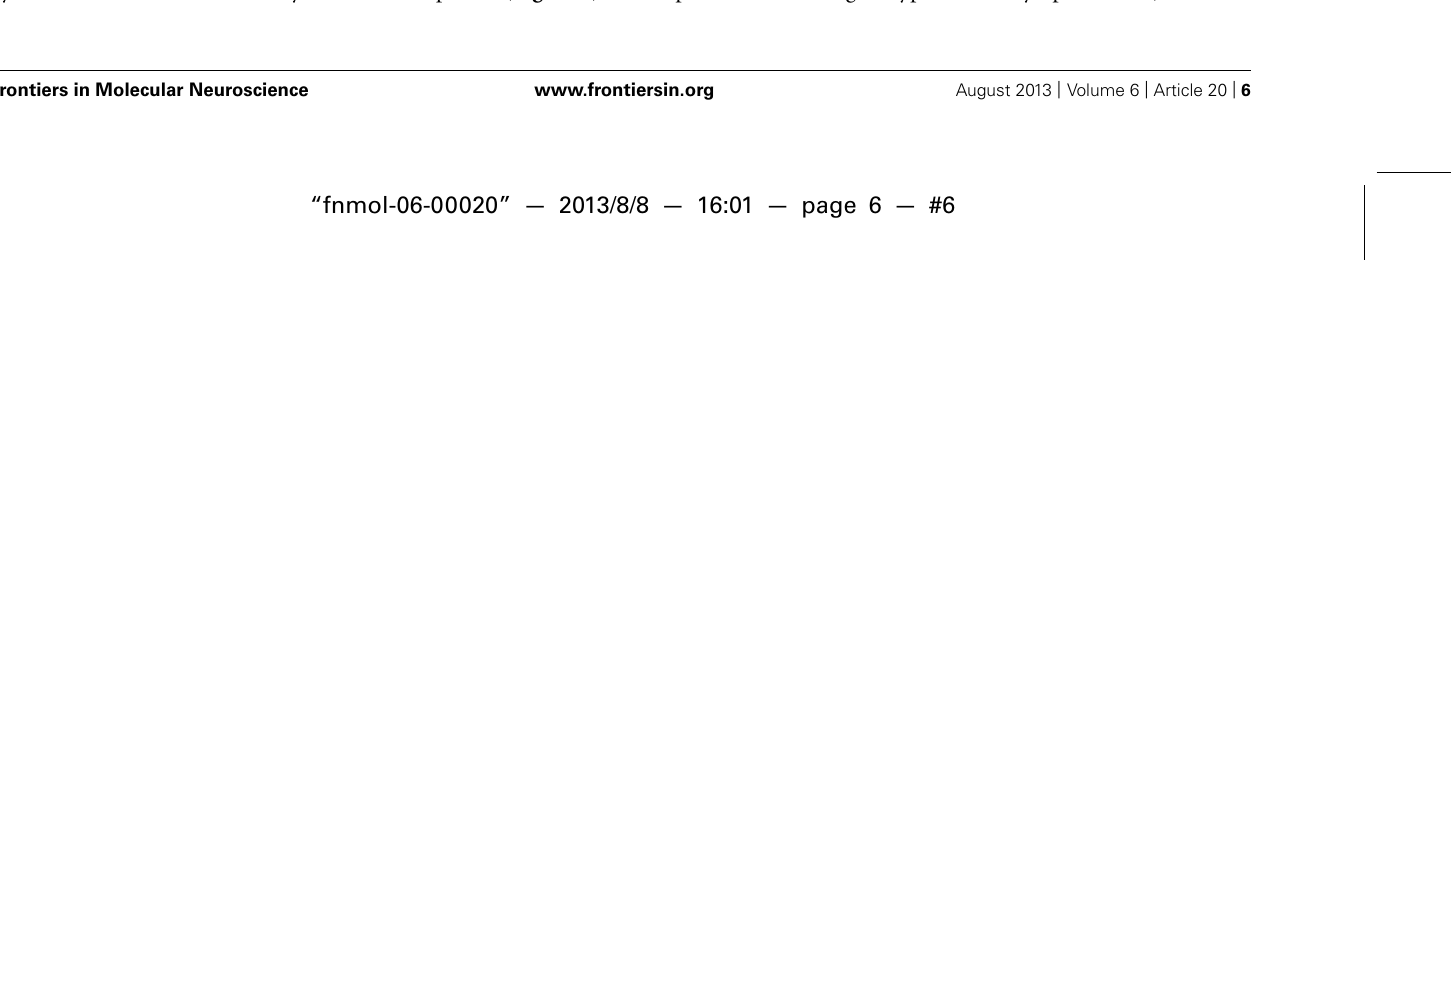
ribbon number ± SD are not significantly different (two-way ANOVA, p = 0.260) between control and Ca V 1.2 Pax2 KO mice in apical, medial, and midbasal cochlear turns (control: n = 4 cochleae, 3 mice; KO: n = 3 cochleae, 3 mice). (D) Mean ± SEM click-evoked ABR wave I amplitude growth function for Ca V 1.2 Egr2 KO mice (green squares) and controls (Ca V 1.2 Egr2 control, black and gray area). ABR wave I amplitudes were not significantly different (two-way ANOVA, p = 0.784) between KO ( n = 7–11 ears, 4–8 mice) and controls ( n = 12–13 ears, 7 mice).The black and green waveforms in the inset depict representative ABR traces measured from one individual ear of a Ca V 1.2 Egr2 control mouse and KO mouse, respectively, evoked at the level of 65 dB above the hearing threshold. (E) Mean ± SEM click-evoked ABR wave III amplitude growth function for Ca V 1.2 Egr2 KO mice and controls. ABR wave III amplitudes were not significantly different (two-way ANOVA, p = 0.281) between KO ( n = 9–12 ears, 5–7 mice) and controls ( n = 10–11 ears, 6 mice). (F) Mean ± SD IHC ribbon counts for Ca V 1.2 Pax2 control (control, white bars) and Ca V 1.2 Pax2 KO mice (KO, green bars) in apical, medial, and midbasal cochlear turns. No significant difference (two-way ANOVA, p = 0.446) between the number of ribbons in control and Ca V 1.2 Egr2 KO mice (control: n = 3 cochleae, 3 mice; KO: n = 3 cochleae, 3